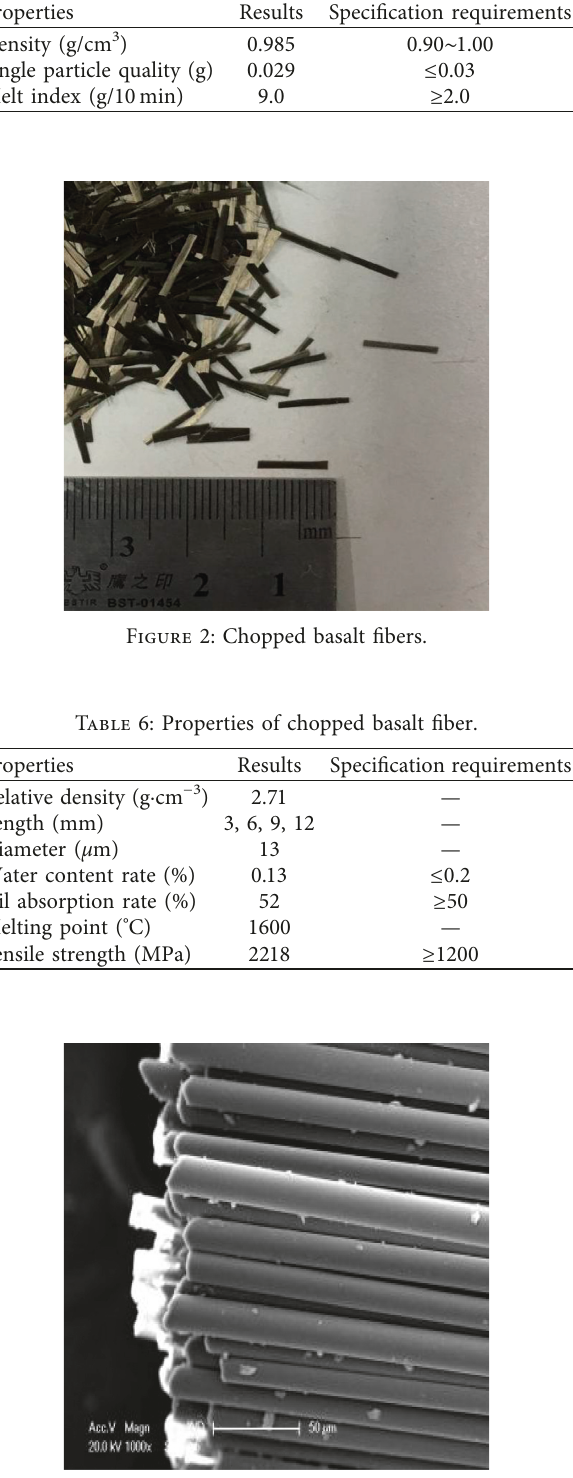
Figure 3: SEM micrograph of chopped basalt fibers.